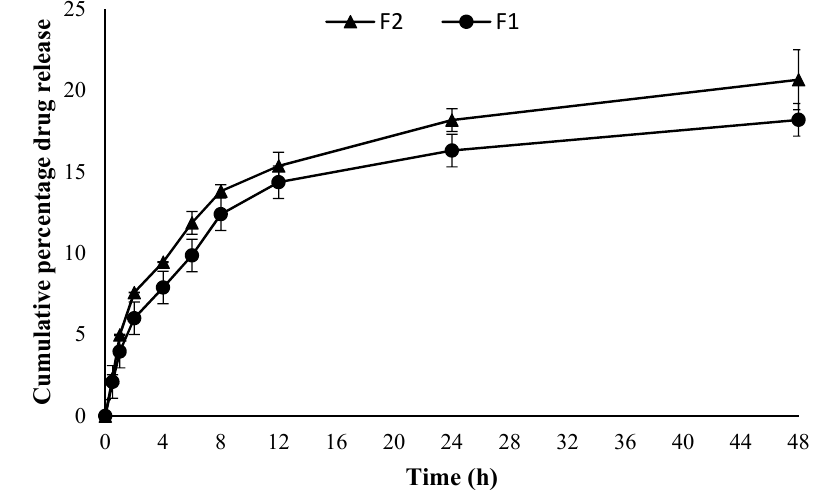
Figure 2. Cumulative percentage drug release ( n = 3, ±SD).